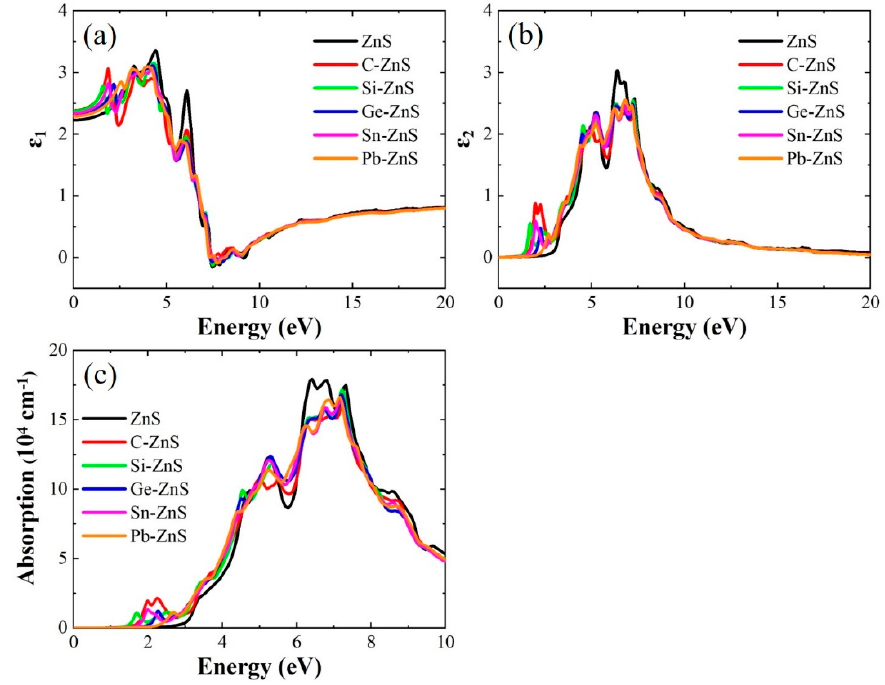
Figure 8. The ( a ) real and ( b ) imaginary parts of the dielectric function, and ( c ) optical absorption of ZnS monolayer and the doped